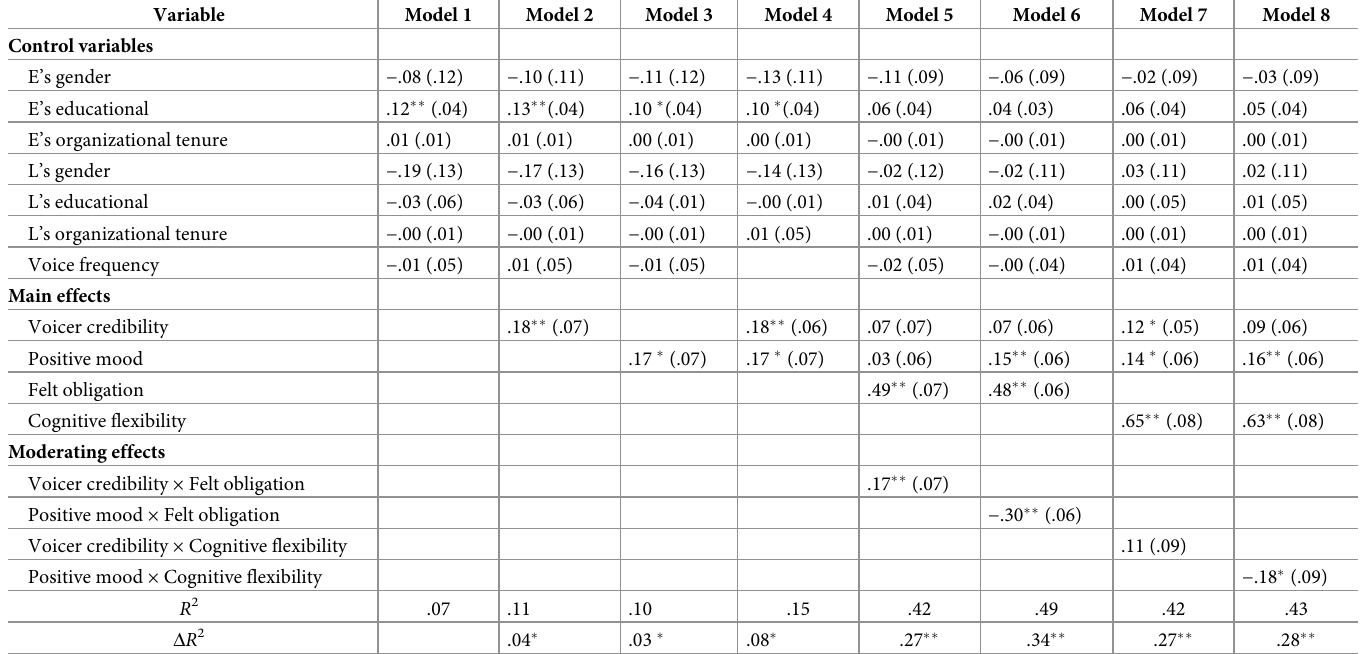
Table 4. Results of hierarchical regression